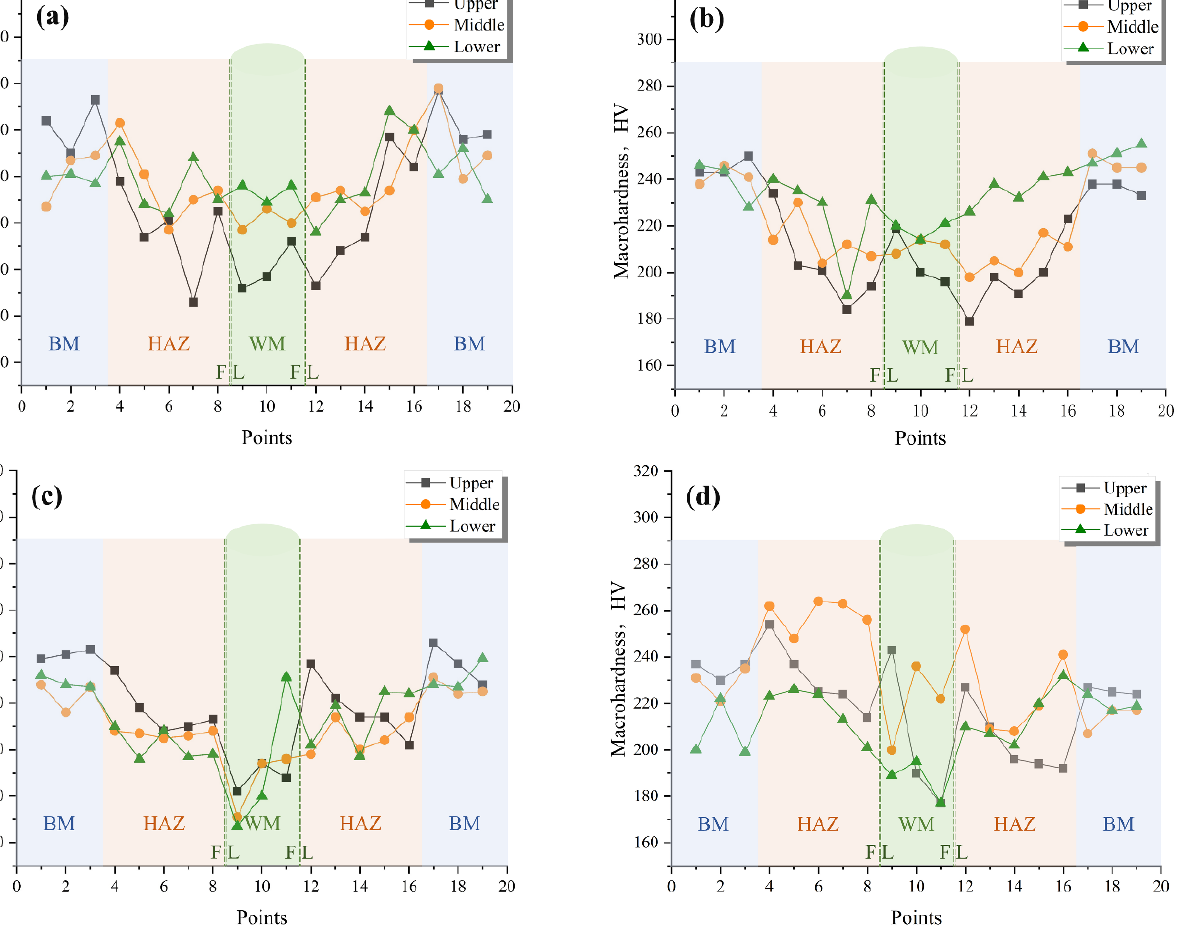
Figure 9. Vickers hardness of the welded joint: ( a ) SM ‐ 1; ( b ) SM ‐ 3; ( c ) SA ‐ 1; ( d ) GT ‐ 1.3.7. Microstruc ‐